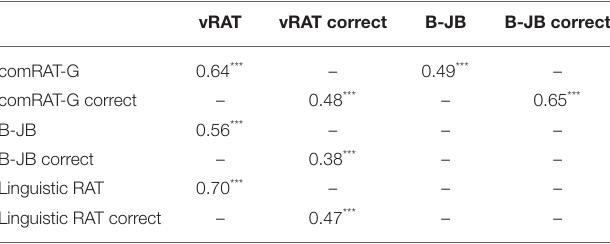
TABLE 5 | Correlations of response times for all metrics for all the participants of Study-2.